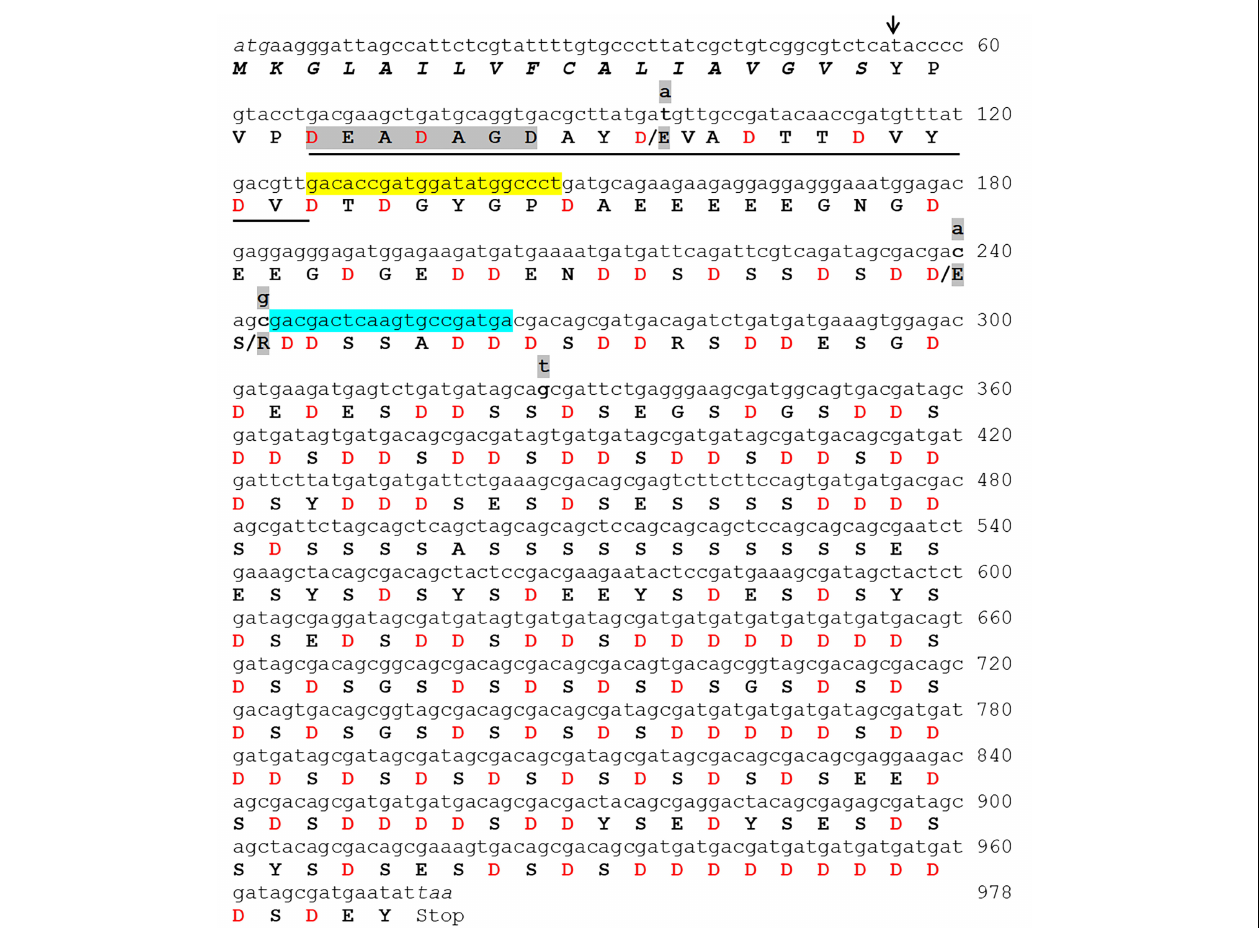
FIGURE 3 | The complete folian-cv1 gene and deduced amino acid sequence. Two copies of folian-cv1, identical with the exception of four point mutations, were identified. The full sequence is shown for copy 1. The point mutations shown in copy 2 occur in the N-terminal region of the protein and are indicated in lower case highlighted letters above the DNA sequence. Three of the four mutations resulted in an amino acid change indicated by the highlighted amino acids following the “/”. Mutations at positions 96 and 240 result in a substitution for Asp to Glu. The mutation located at position 243 resulted in a change from serine to arginine. The putative signal sequence starting with the ATG start codon appears in italics. The putative cleavage site of the signal sequence is indicated with an arrow ( ↓ ) and cleaves between the “S” and “Y” residues. The deduced amino acid sequence minus the signal sequence encodes a 307 amino acid product enriched in aspartic acid and serine. The underlined sequence matches well with the N-terminal sequence identified by Edman sequencing ( Table 2 ) and the gray highlighted sequence “DEADAGD” was used to design the in silico probe which identified the transcript used to screen the BAC library. The yellow highlighted region from 127 to 146 bp and the blue highlighted region from 263 to 244 bp indicate the regions that were used to construct forward and reverse primers respectively for subsequent PCR analyses.